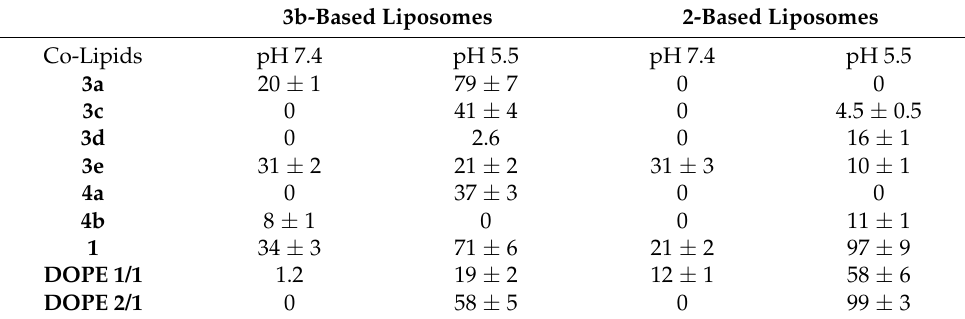
Table 3. Membrane fusion potential of liposomes (%).